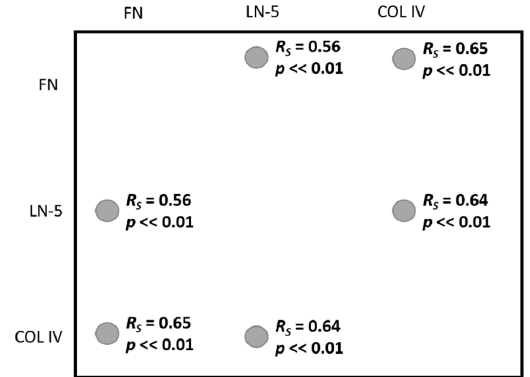
Figure 4. Correlation between LN-5, FN, and COL IV.